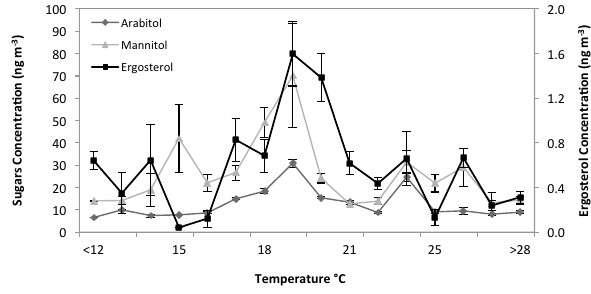
Fig. 5. Correlation between ambient ergosterol, arabitol and man- nitol levels and temperature at the sampling site. The maximum values of all biomarkers appear between 19–20 ◦ C which are typi- cal average temperatures for the spring and autumn seasons.